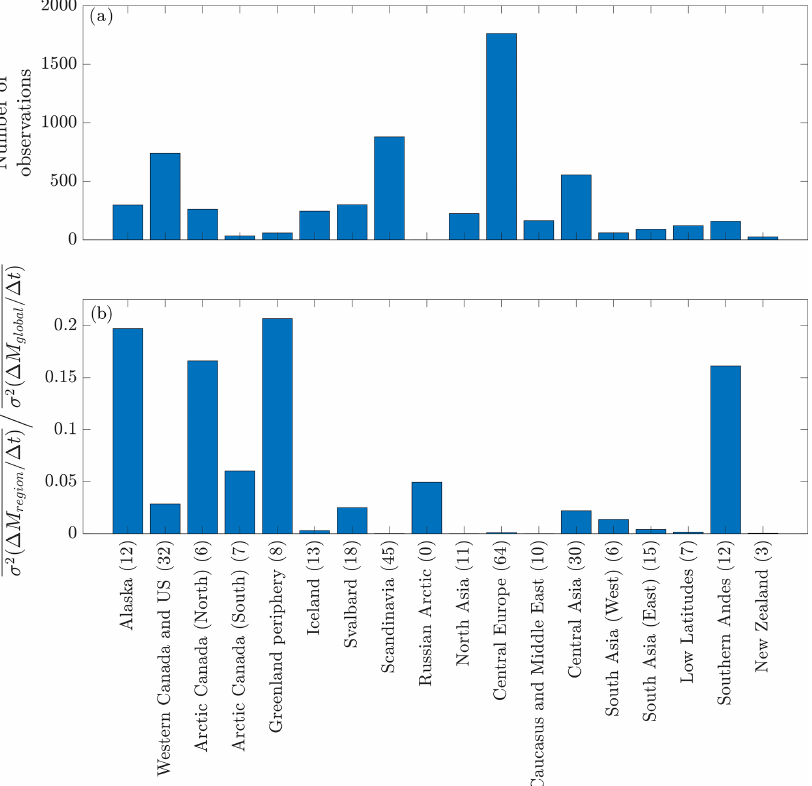
Figure 3. (a) Number of specific annual mass balance observations available for calibration and validation in each RGI region. (b) Fraction of ensemble variance of global mean mass change rate ( (cid:49)M/(cid:49)t ) in the modeled period (1901–2018) attributable to each RGI region. In brackets is the number of glaciers used for calibration and validation in each region.